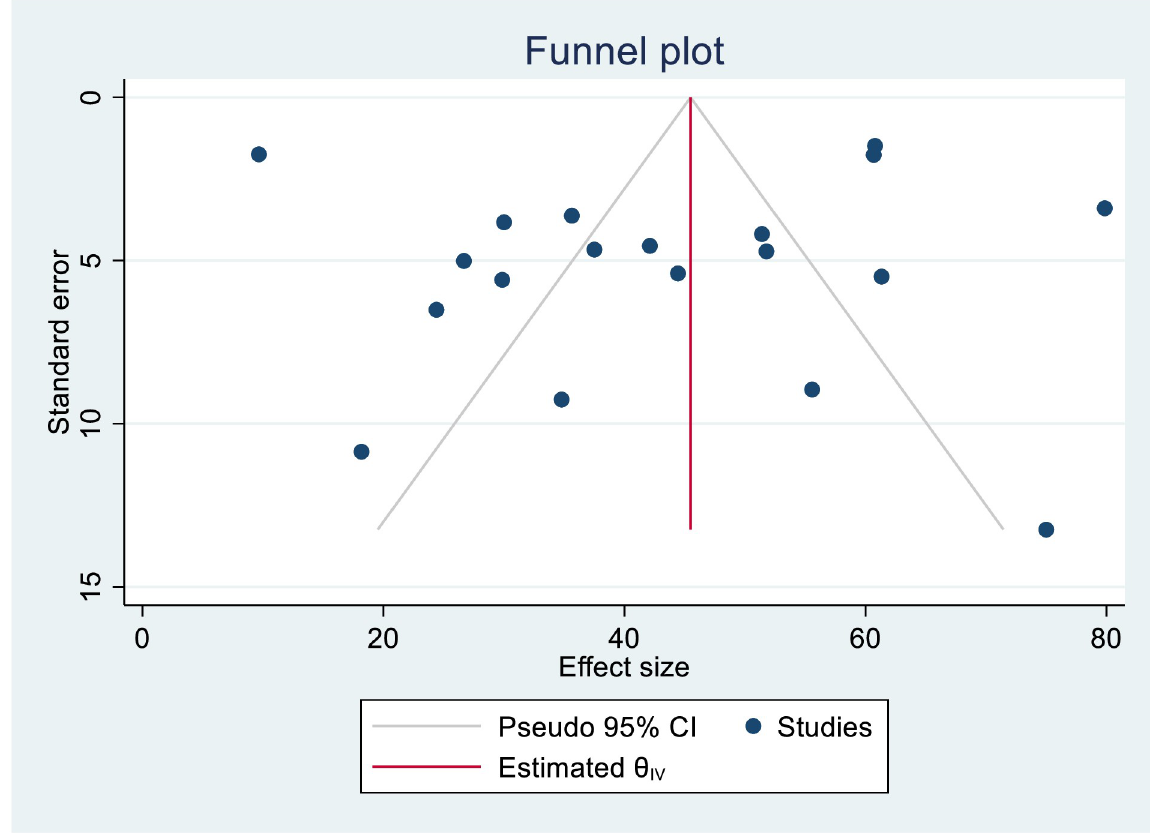
Fig 9. Funnel plot showing publication bias among studies used to compute the incidence of mortality in patients with extensively drug- resistant tuberculosis.